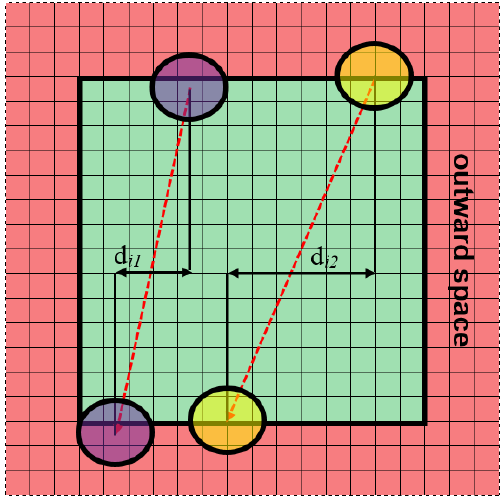
Figure 8. Combined boundary conditions.